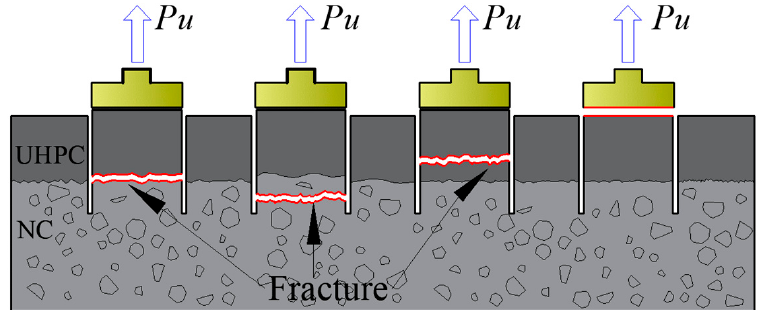
Figure 6. Possible failure modes of the pull-o ff test.